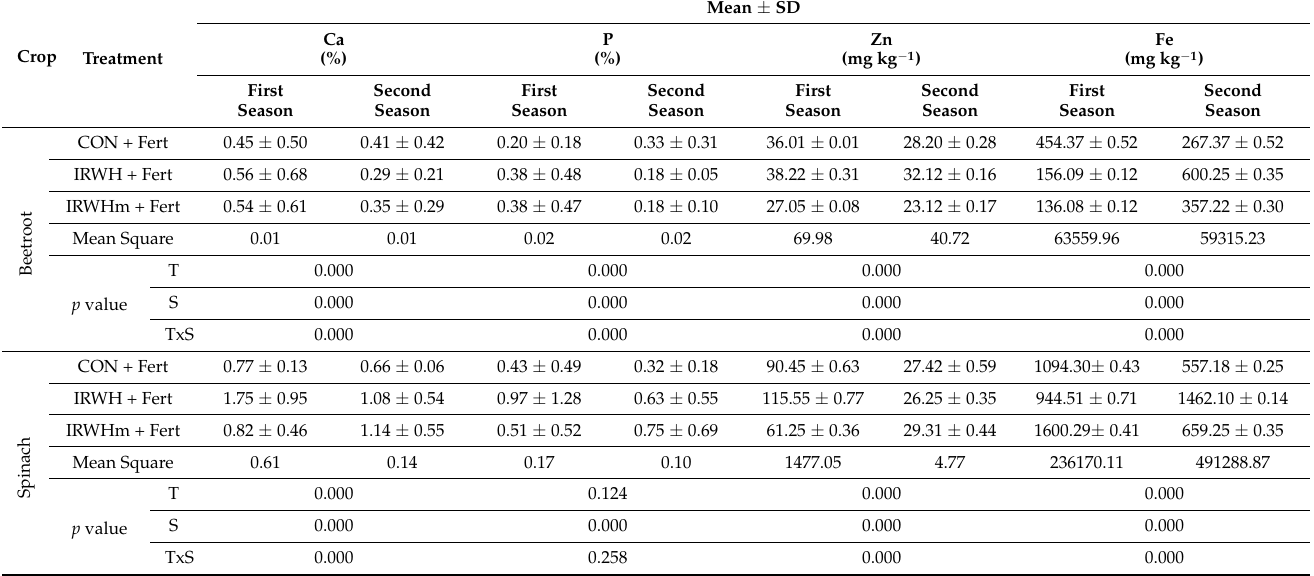
Table 5. Effect of season, agronomic treatments and water-use technology on the mineral levels of different vegetables in Swayimane, KwaZulu-Natal province ( w / w , on dry matter